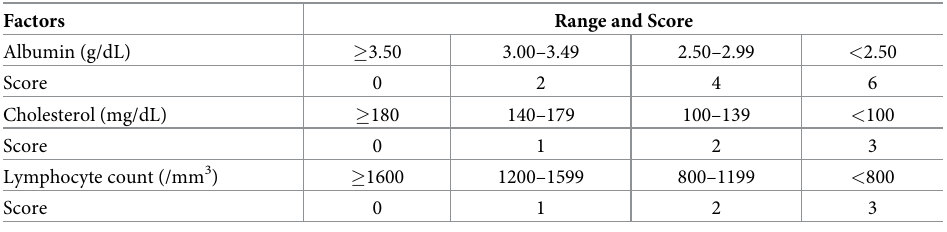
Table 2. Assessment of patient nutritional status by the CONUT